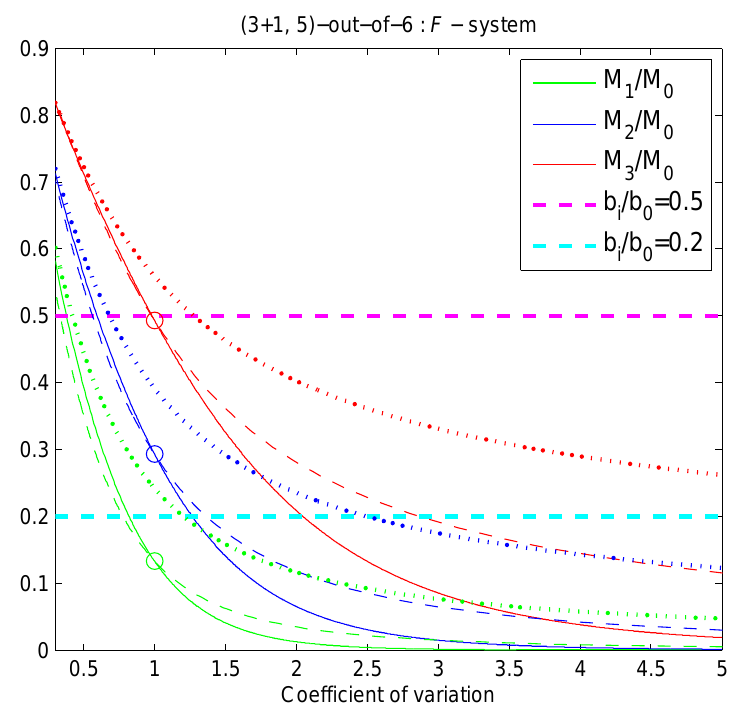
Figure 4. The dependence of the ratios M l / M 0 for different distributions of system components life- time versus their coefficient of variation for ( 3 + 1,5 ) -out-of-6 : F system. Solid lines— Γ -distribution, dashed lines— GW -distribution, dotted lines—log-normal distribution, circles—exponential distribu-